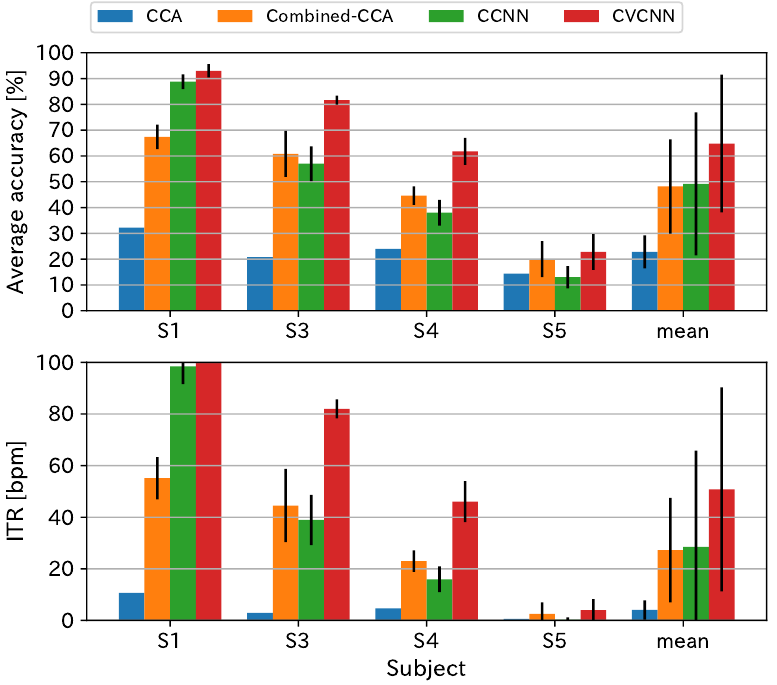
Figure 3. Classification accuracy and ITR for the original dataset with a data length of 1000